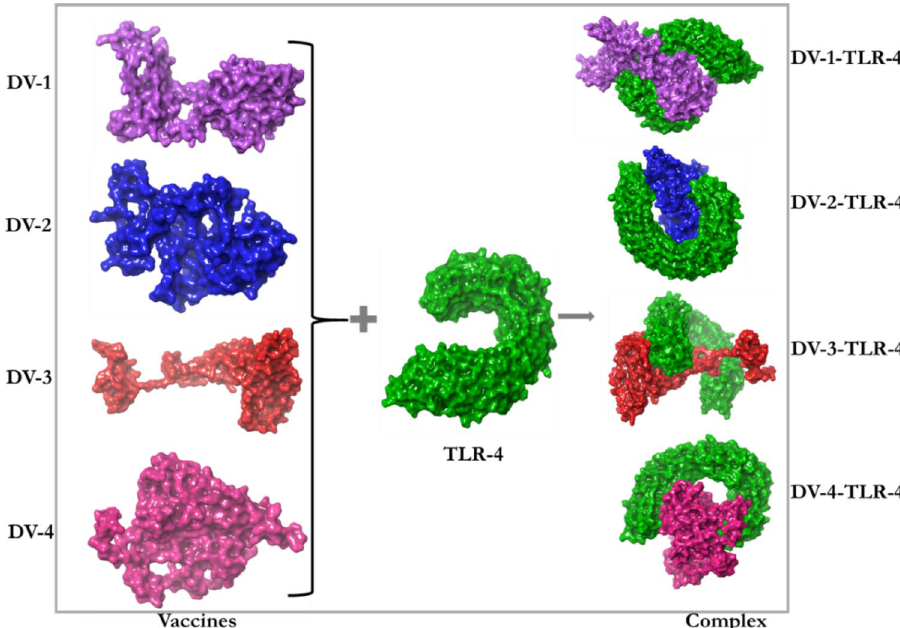
Figure 7. The solid molecular surface display of the predicted vaccines docked to the TLR-4 receptor.